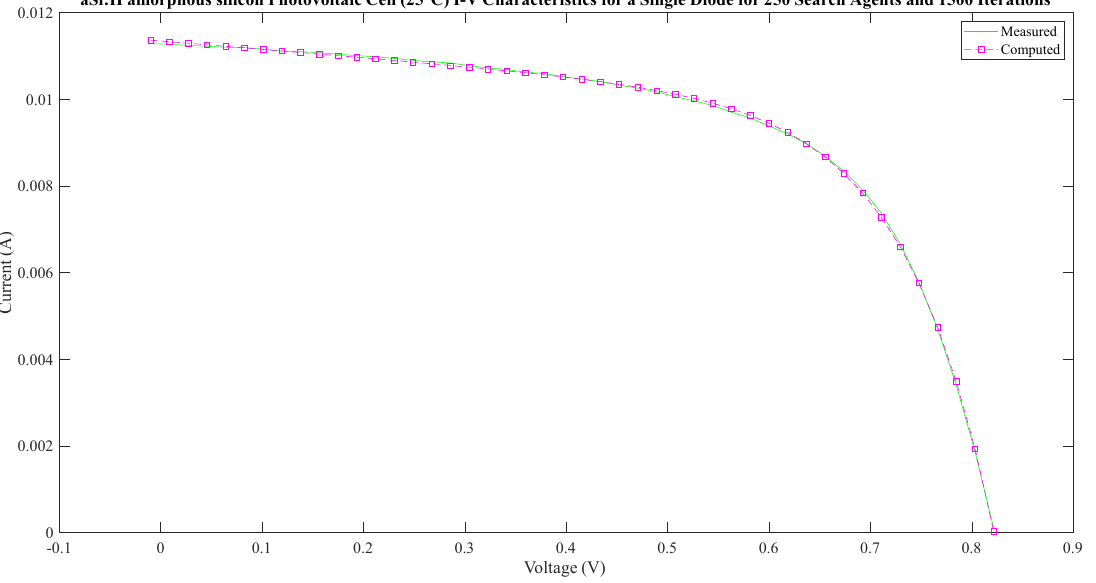
Figure 5. The current-voltage characteristics of amorphous silicon photovoltaic cell (SDM).